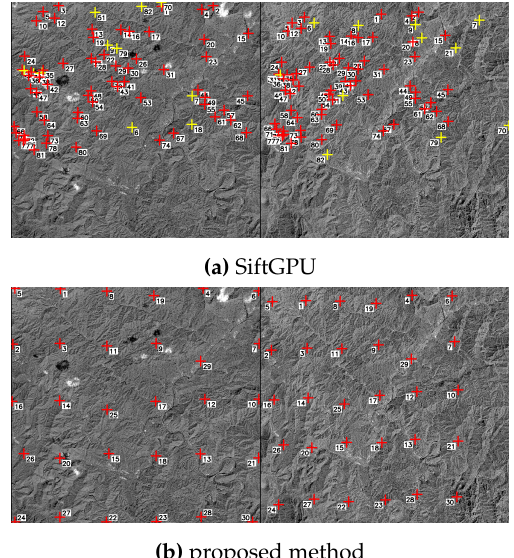
Figure 8. Matching results of GF-2 PAN images, using SiftGPU and the proposed method. In each sub-figure, the left is the image captured on 3 September 2015 and the right is the image captured on 12 September 2015. The matched points are labeled by the same numbers, and red crosses stand for correct matches, while yellow crosses stand for wrong matches. ( a ) The result of SiftGPU (71 correct matches and 11 wrong matches); and ( b ) the result of proposed method (30 correct matches are